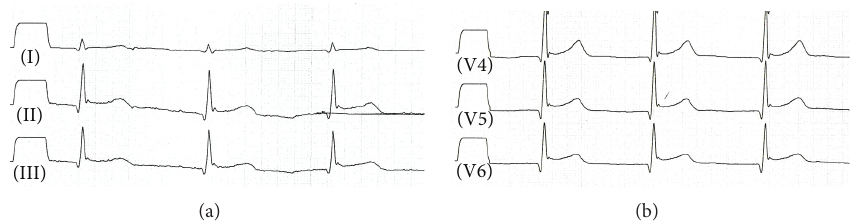
Figure 1: Initial 12-lead electrocardiogram: sinus rhythm and ST-segment elevation with upward concavity in leads II, III, aVF, and V4–V6.